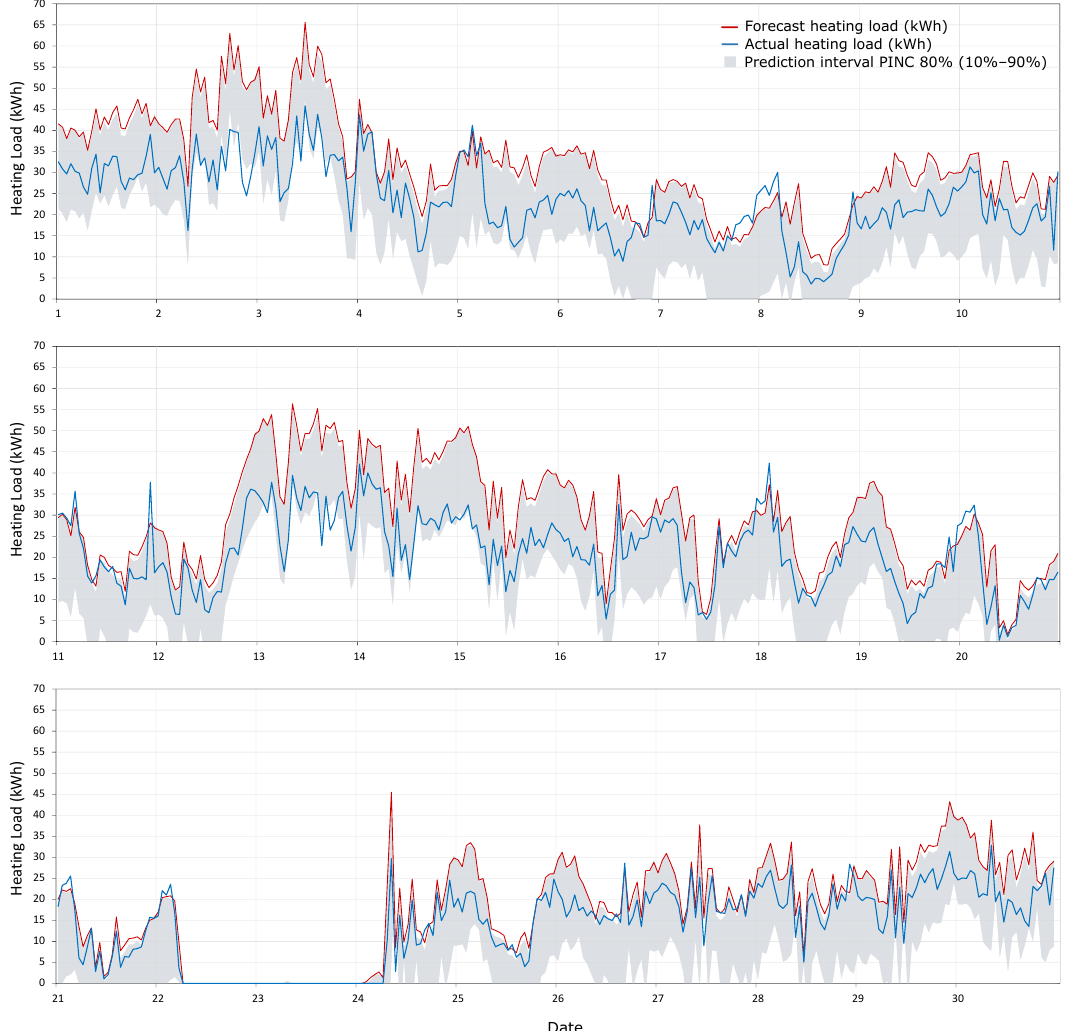
Figure 11. Results for the validation of the probabilistic load forecasting methodology for the